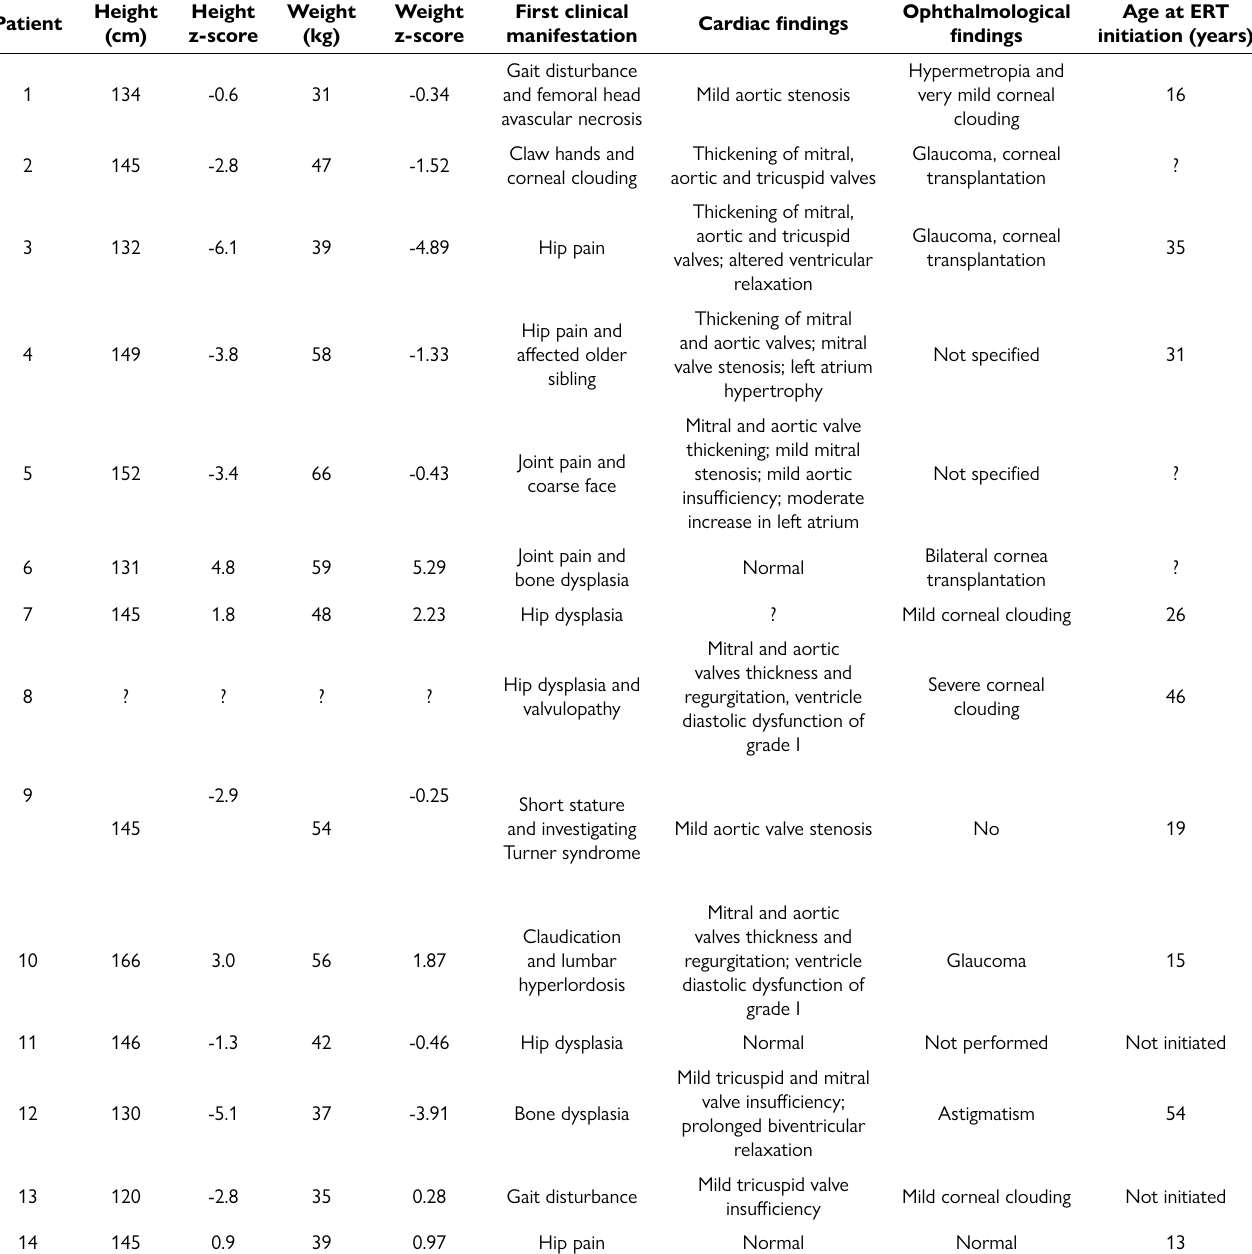
Table 2 – Outcomes of anthropometric, cardiac and ophthalmological finding in the study cohort